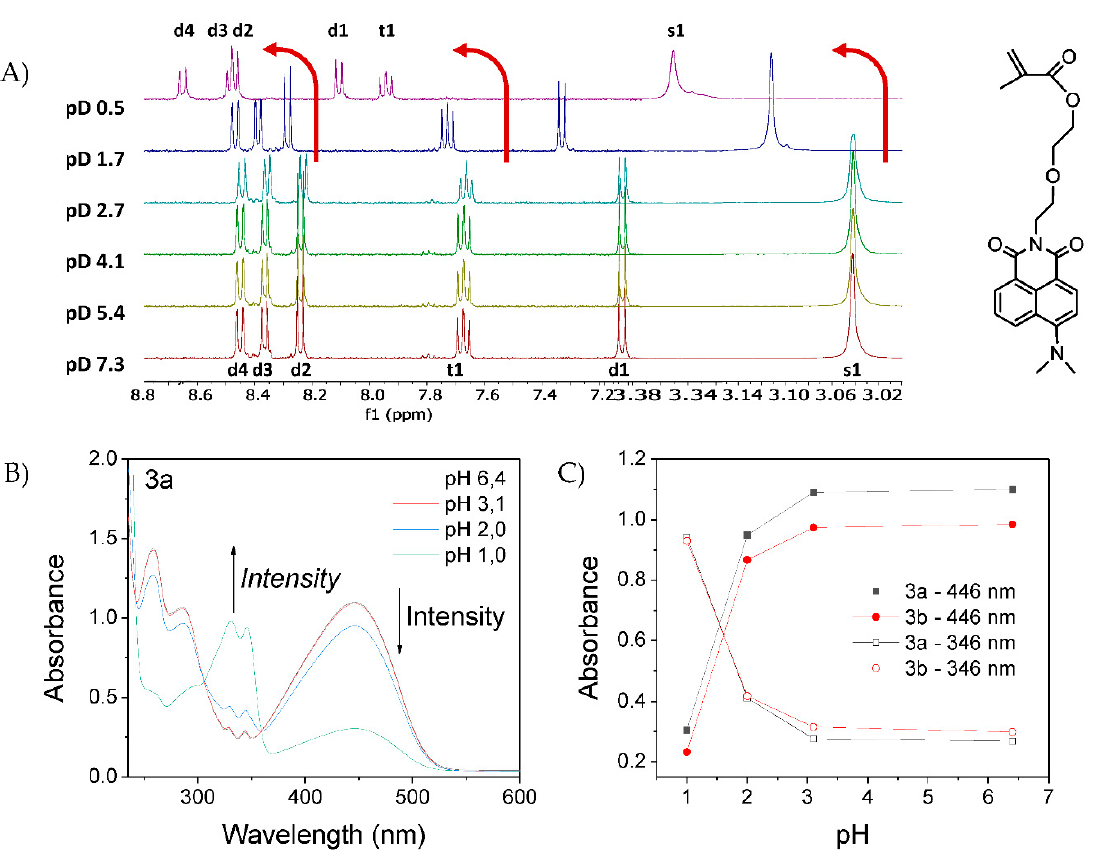
Figure 6. ( A ) 1 H NMR spectrum of compound 3b in D 2 O/DMSO-d 6 (1/4) (1:2) and hydrochloric acid (DCL 37%) solution; ( B ) absorbance spectra of 3a at different pH; and ( C ) Comparison of the absorption changes with pH for 3a and 3b .